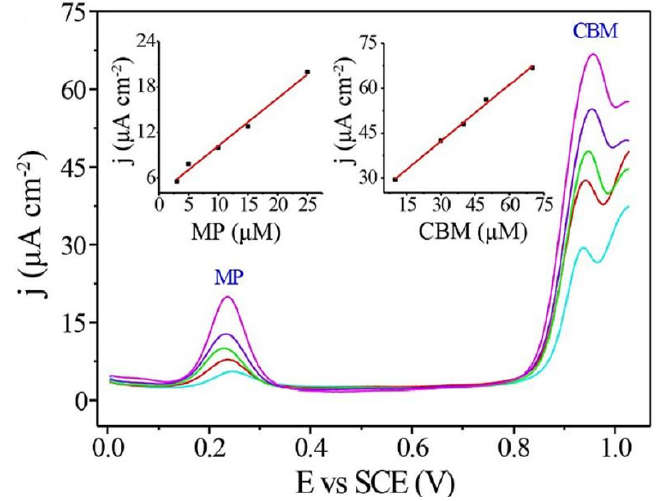
Figure 2. Simultaneous detection of the mixture of methyl parathion (MP) and carbendazim (CBM). The concentration ranges are (3 – 25) × 10 3 μM for MP and (1 0 – 70) × 10 3 μM for CBM. The insert profiles show the calibration curves between the peak current density and the target pesticide concentration. Reprinted from [70].